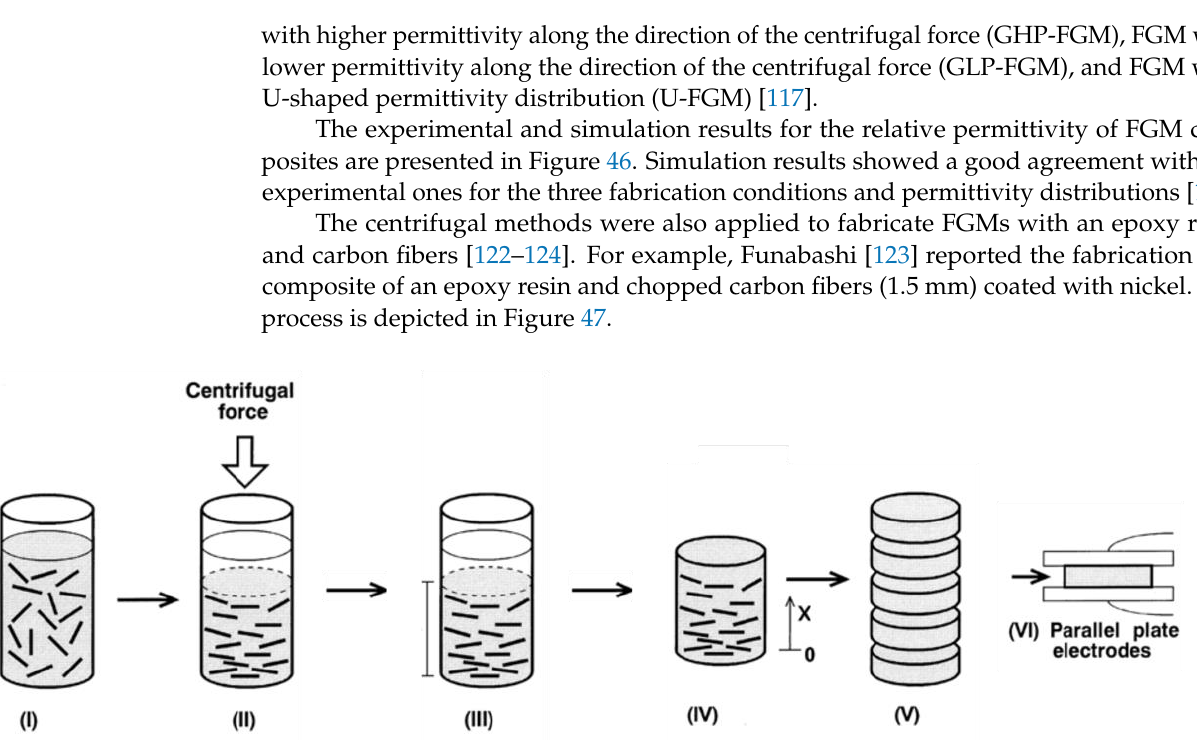
Figure 47. Schematic of sample preparation and measurement. ( I ) Resin and fibers before centrifugation, ( II ) direction of centrifugal force, ( III , VI ) sample after centrifugation, ( V ) sample cut in different specimens of 1.5 mm thickness, ( VI ) configuration for electrical characterization. Reprinted from [123], Copyright 1997, with permission from Elsevier.